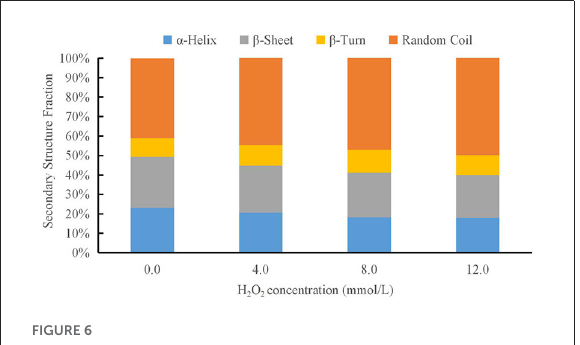
FIGURE6 Changes in secondary structure composition of duck myofibrillar protein (DMPs) gels pretreated with various hydroxyl radicals levels (H 2 O 2 concentrations: 0, 4, 8, 12